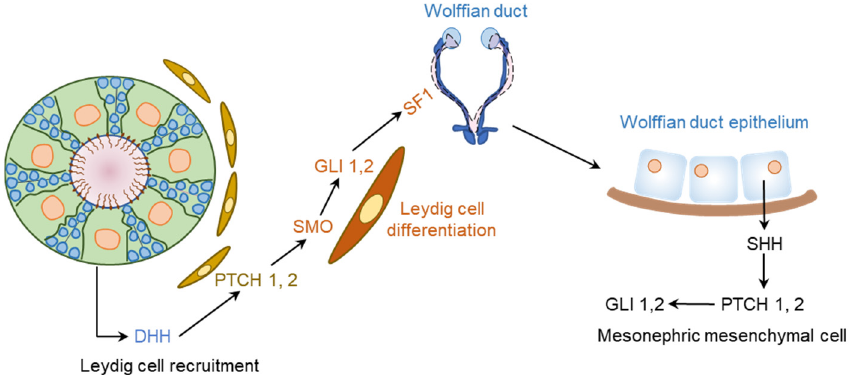
Figure 8. DHH regulation of male gonadal development. The fetal testis is composed of testis cords that contain the developing germ cells and Sertoli cells (SCs), as well as vascular networks. These structures are surrounded by an interstitial tissues compartment containing Leydig cells (LCs). DHH secreted by the SCs signals through PTCH1 and GLI1 in the LCs to regulate their development and overall organization of the testis cord. DHH signaling also induces the expression of SF1 in LCs, which upregulates the expression of steroidogenic enzymes. On the other hand, SHH is expressed in the Wolffian duct epithelium, and the cells in mesonephric mesenchyme express PTCH1, SMO, and GLI1. Thus, the two HH signaling pathways may take part into the epithelial–mesenchymal communication during the male reproductive tract development.